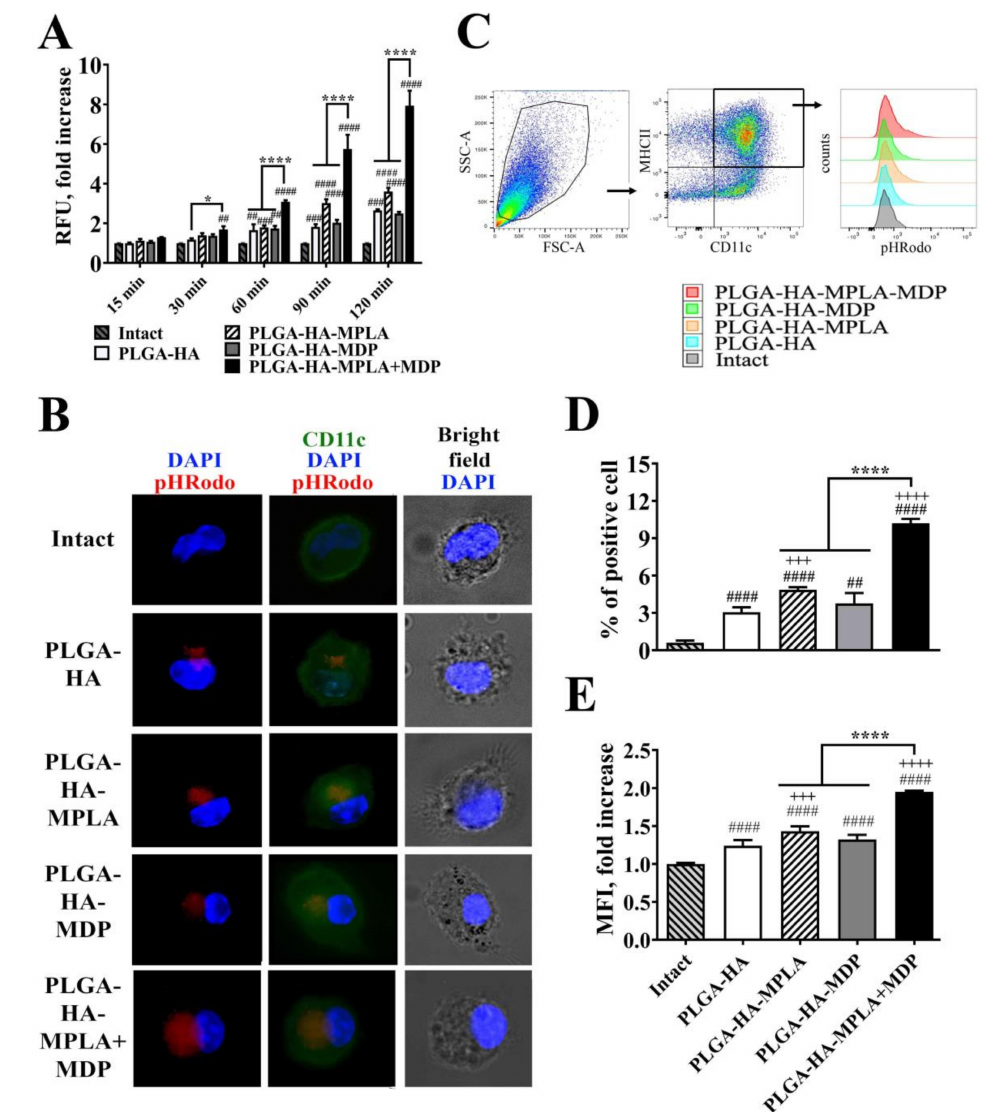
Figure 2. PLGA NPs containing both MPLA and MDP are more effectively phagocytosed by bone marrow-derived dendritic cells (BMDCs) compared to NPs containing individual PRR agonists. ( A ) A time course of phagocytosis quantification by BMDCs of PLGA NPs containing pHRodo-stained